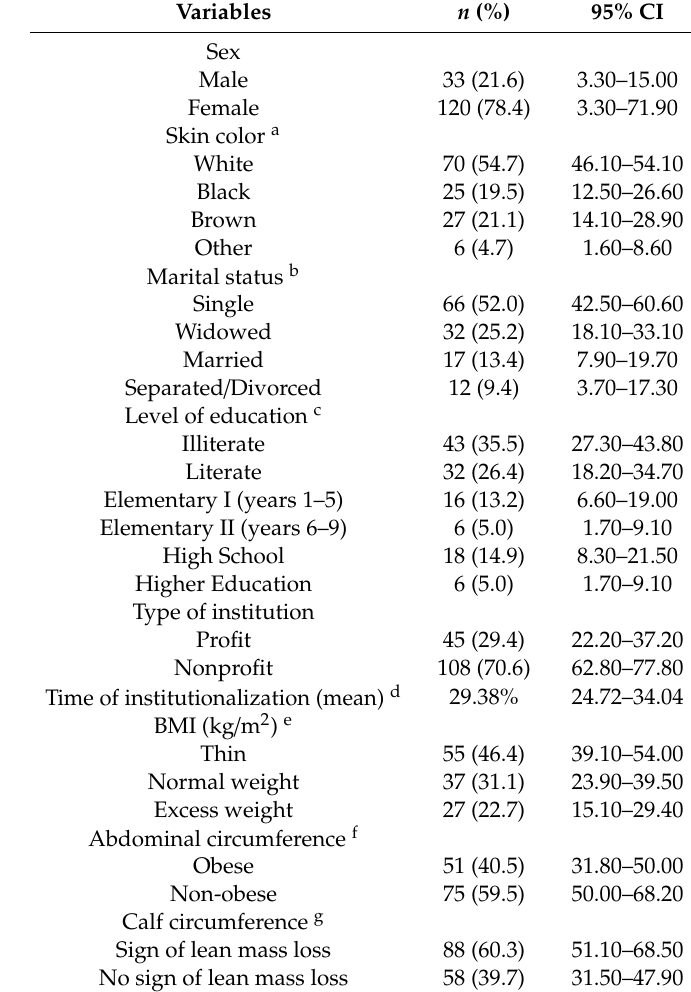
Table 1. General, anthropometric, lifestyle, and health characteristics of institutionalized elderly individuals ( n =